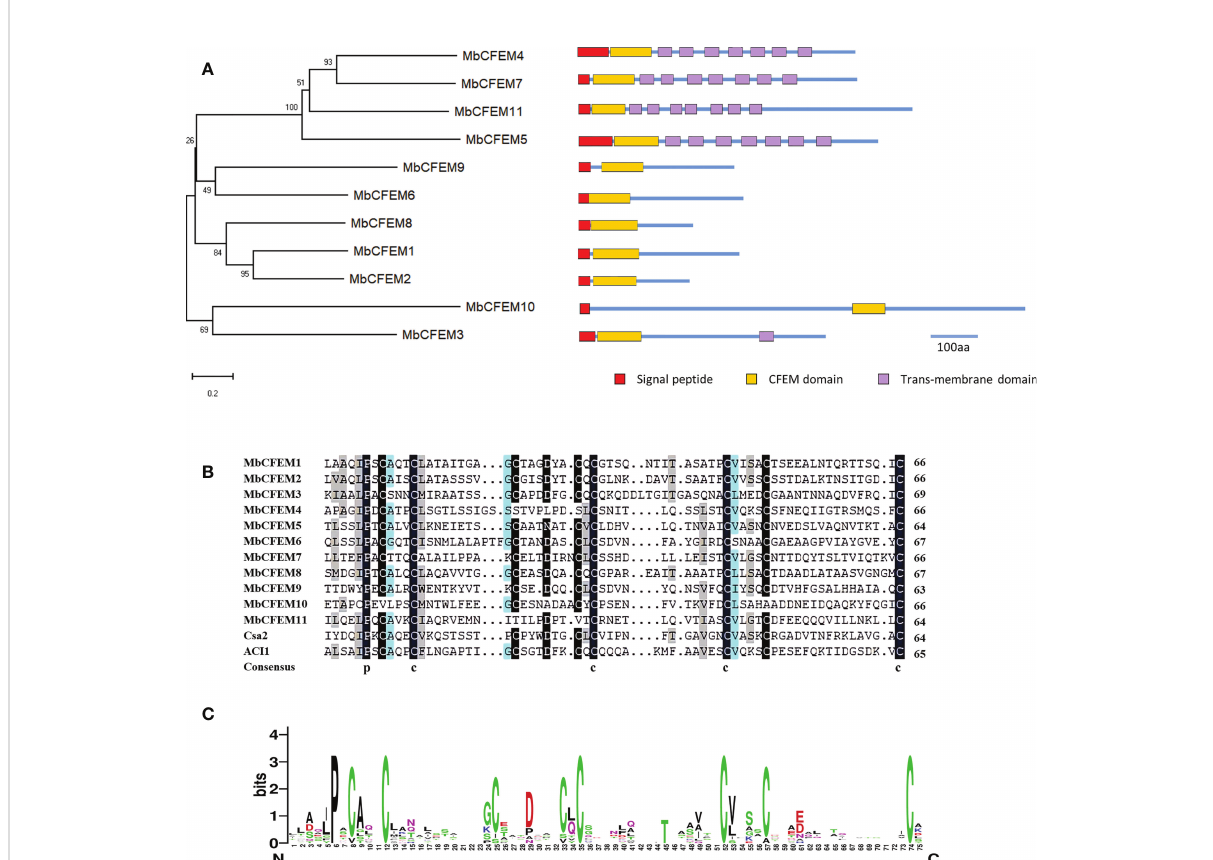
FIGURE 1 Bioinformatics analysis of Common in Fungal Extracellular Membrane (CFEM) proteins in M. brunnea. (A) Phylogenetic analysis of Common in Fungal Extracellular Membrane (CFEM) proteins in M. brunnea . A neighbor-joining phylogenetic tree was constructed based on the amino acid sequences of MbCFEM proteins. The numbers at nodes represent the percentage of their occurrence in 1000 bootstrap replicates; the nodes supporting less than 50% are not shown. Maps of the corresponding MbCFEM proteins are shown on the right. The red box represents the signal peptide, the yellow box represents the CFEM domain, and the purple box represents the trans-membrane domain. Scale bar = 100 amino acids (aa). (B) Multiple amino acid sequence alignment in Fungal Extracellular Membrane (CFEM) domains from 11 MbCFEM proteins. Alignments were performed with ClustalW and modi fi ed with DNAMAN. Conserved amino acids are highlighted in black, blue, and grey in descending order of conservatism. (C) WebLogo of Common in Fungal Extracellular Membrane (CFEM) domains from 11 MbCFEM proteins. The conservatism degree of amino acids was indicated by the size through